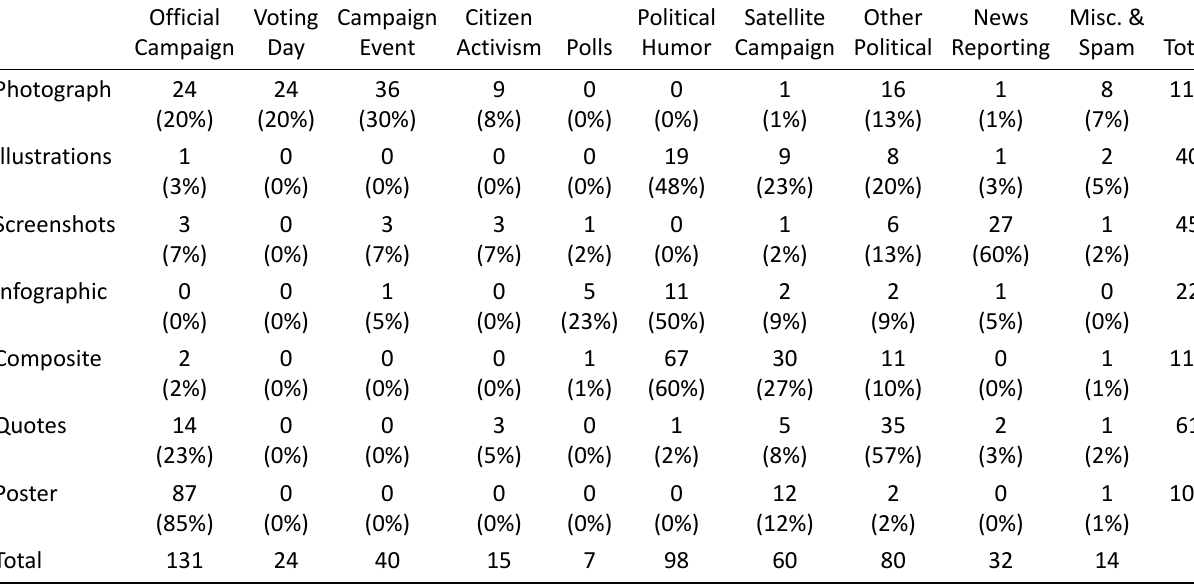
Table 4. Cross tabulations of visual and modal categories in ‘Exit’ sample (N,